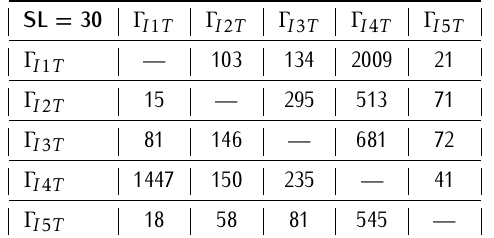
Figure 5. Unique light segments between Γ and Γ for I 1 T I 2 T ≥ 0 . 7 SL=30 and ρ k Repeating the same analysis, between Γ I 1 T and Γ I 3 T the unique light segments are represented in figure 6, between Γ I 1 T and Γ I 4 T the unique light segments are represented in figure 7 and between Γ I 1 T and Γ I 5 T the unique light segments are represented in figure 8. According to spatiotemporal lightmorphic